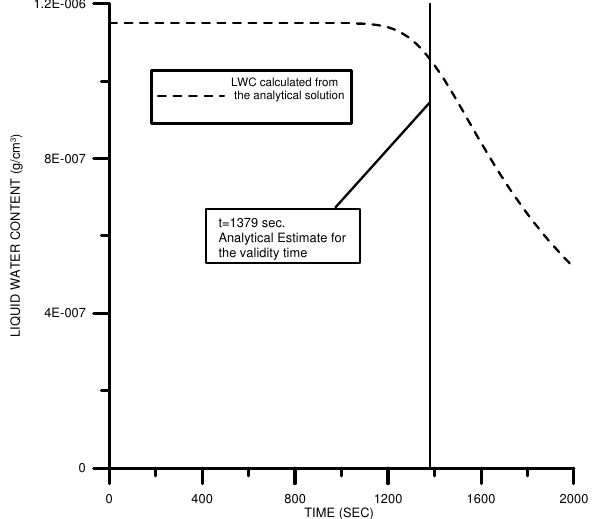
Figure 1. Time evolution of the liquid water content (first moment of the distribution) Fig. 1. Time evolution of the liquid water content (first mo- for the product kernel ( K(x,y)=Cxy, C =5.49×10 10 cm 3 g -2 s -1 ), calculated from the ment of the distribution) for the product kernel ( K(x,y)=Cxy , analytical solution of the KCE. C =5.49 × 10 10 cm 3 g − 2 s − 1 ), calculated from the analytical solu- tion of the KCE.